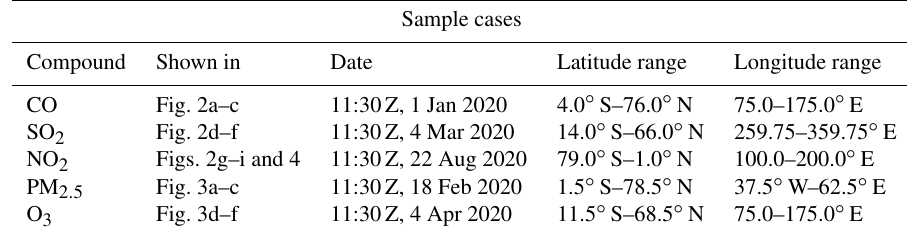
Table A2. Dates and lat–long boundaries for the sample cases shown in Figs.